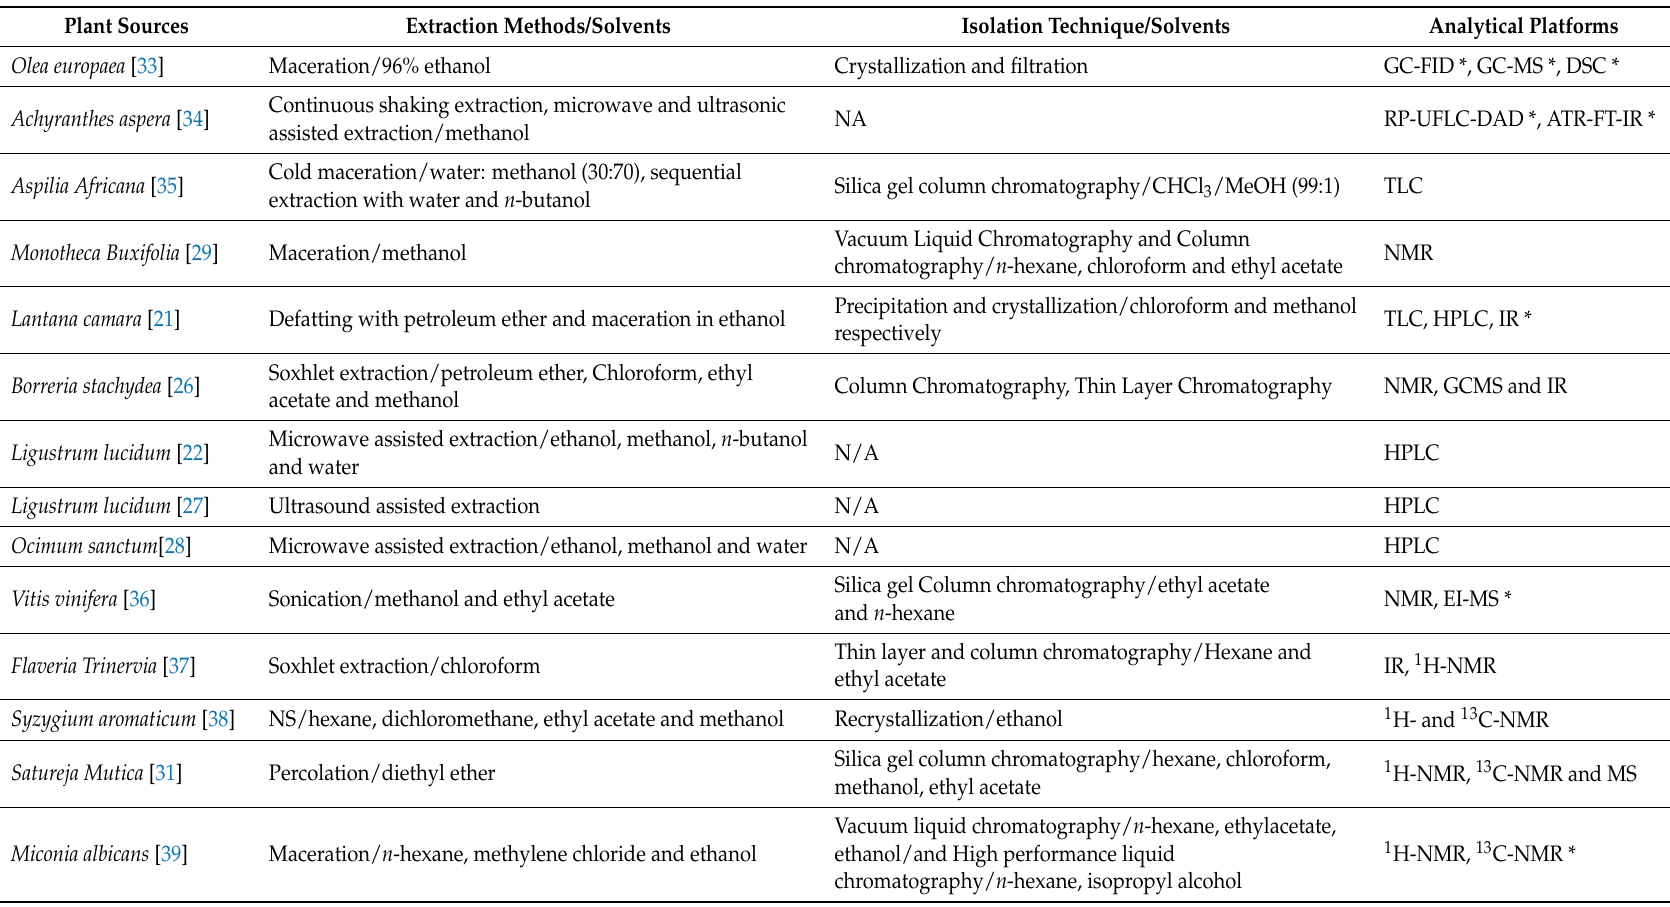
Table 1. Some of the plant sources of oleanolic